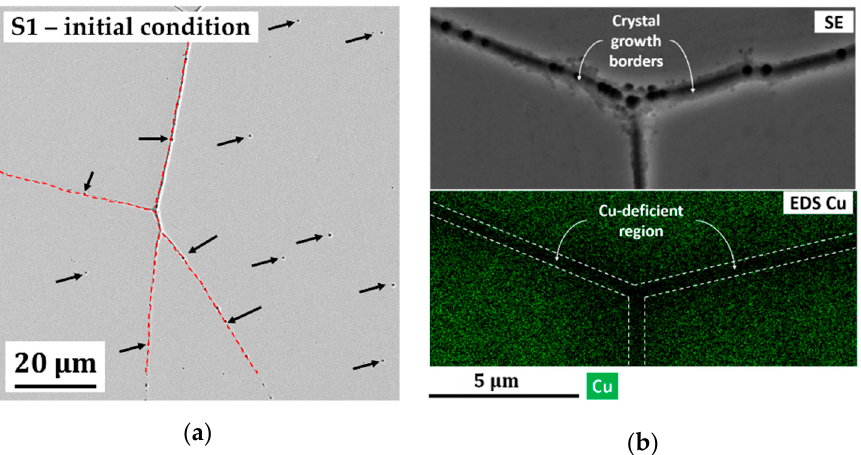
Figure 3. ( a ) Secondary electron (SE) image of initial condition of tensile specimen of S1 surface (planar mode), which shows the presence of micropores (marked with black arrows) and crystal growth borders (marked with red dashed line); ( b ) combined high magnification of a secondary electron (SE) image (upper section) and energy dispersive X-ray spectroscopy (EDS) elemental map of Cu (lower section) shows a Cu-deficient region along crystal growth borders (planar mode).